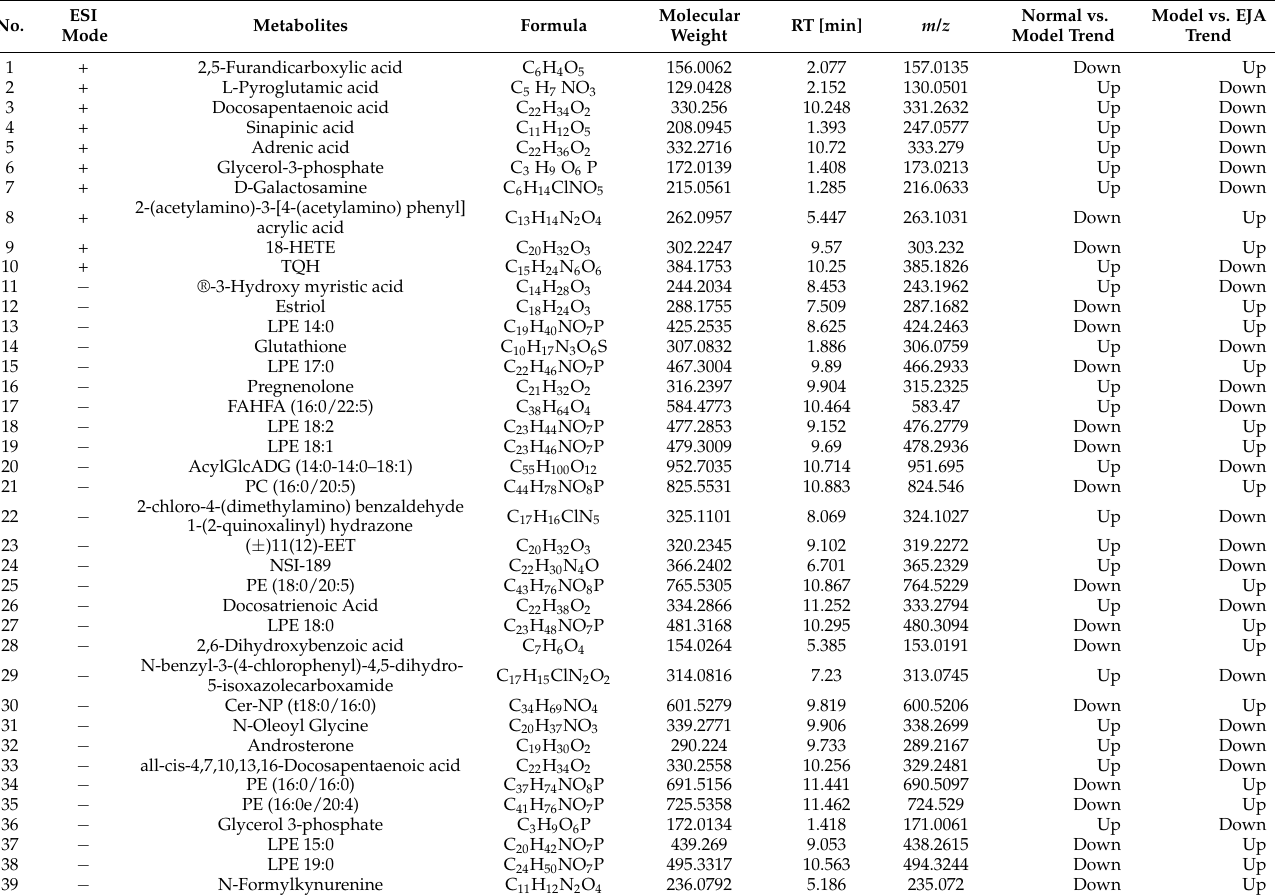
Table 1. Differential metabolites in plasma samples in positive and negative ion